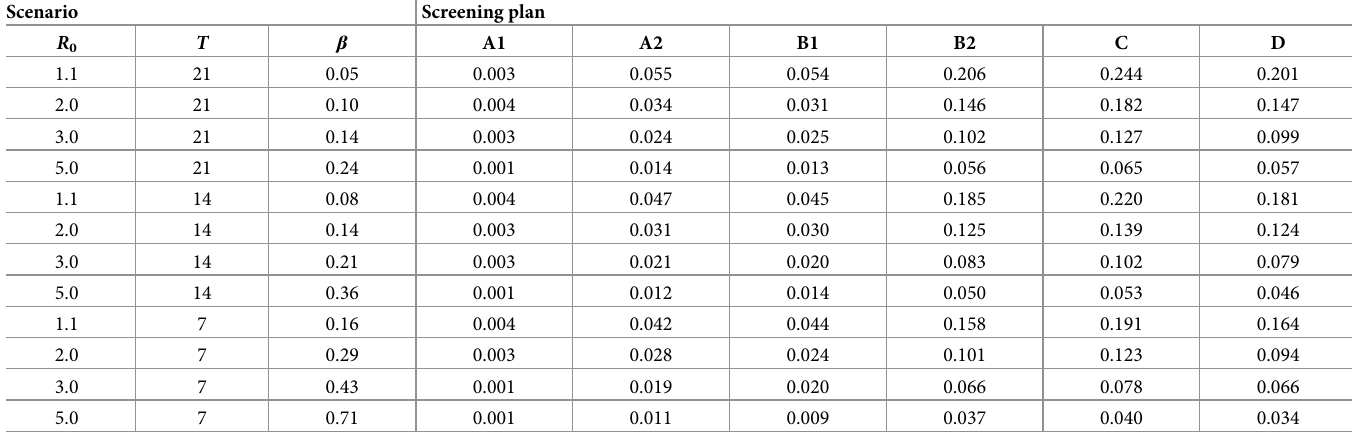
Table 1. Probability of not detecting the outbreak in the class within 28 days from the beginning of the epidemic, by screening plan (A1, A2, B1, B2, C, D), under different epidemic scenarios ( R 0 and T ), assuming that individual tests have sensitivity 0.7 and maximum